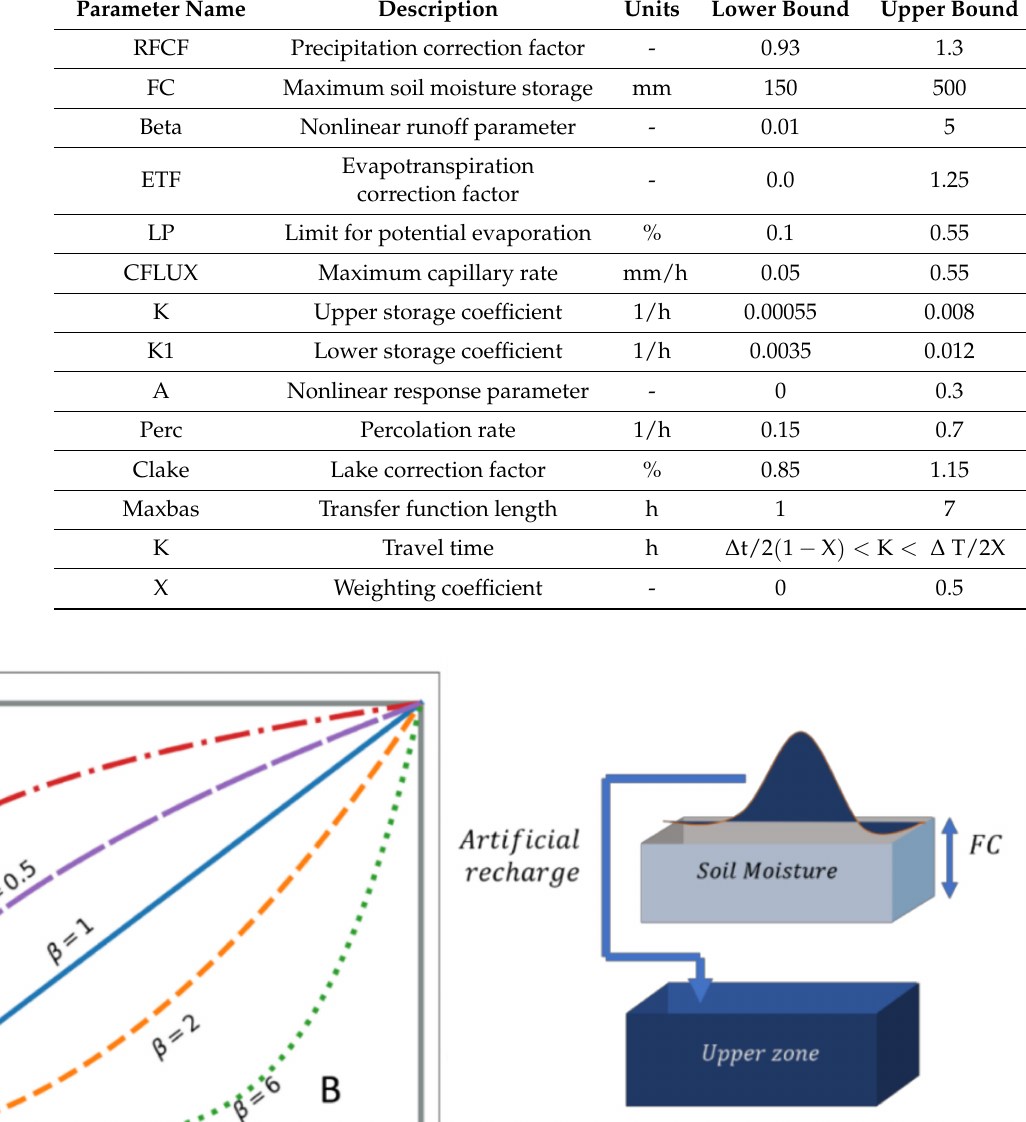
Table 1. HBV parameters and the ranges used in the calibration process.